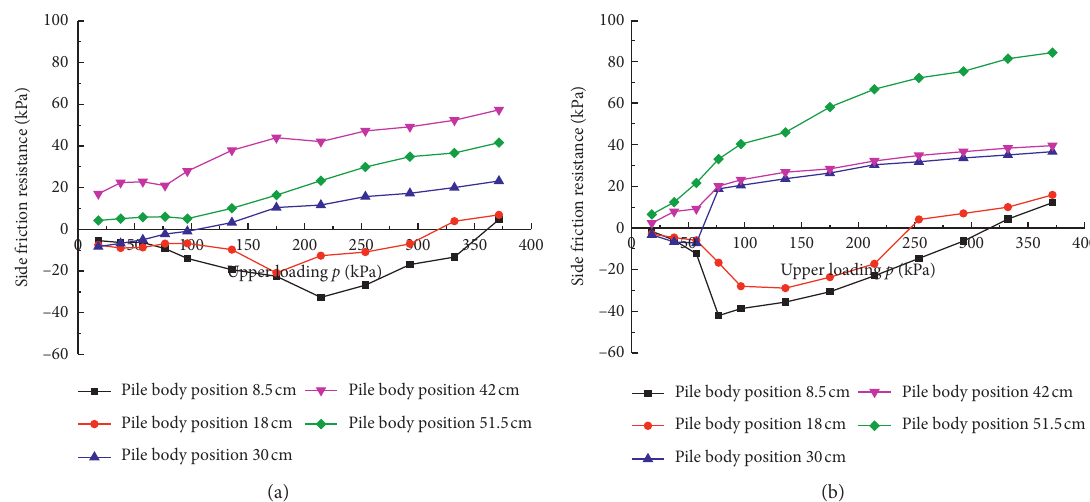
Figure 8: Changes of side friction resistance with the growth of upper load in the group pile composite foundation. (a) Y-3 group pile composite foundation (middle pile); (b) Y-3 group pile composite foundation (side pile).